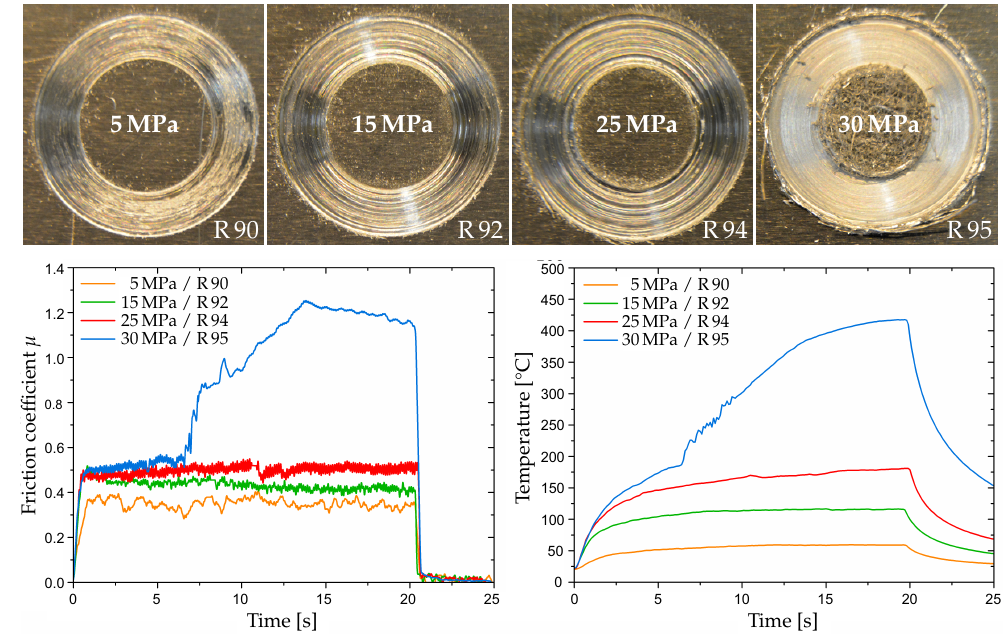
Figure 5. Surfaces, courses of friction coefficients, and temperatures for the example test series (Tool Number 1; spindle speed 500rpm; different surface pressures; forces: moving average over